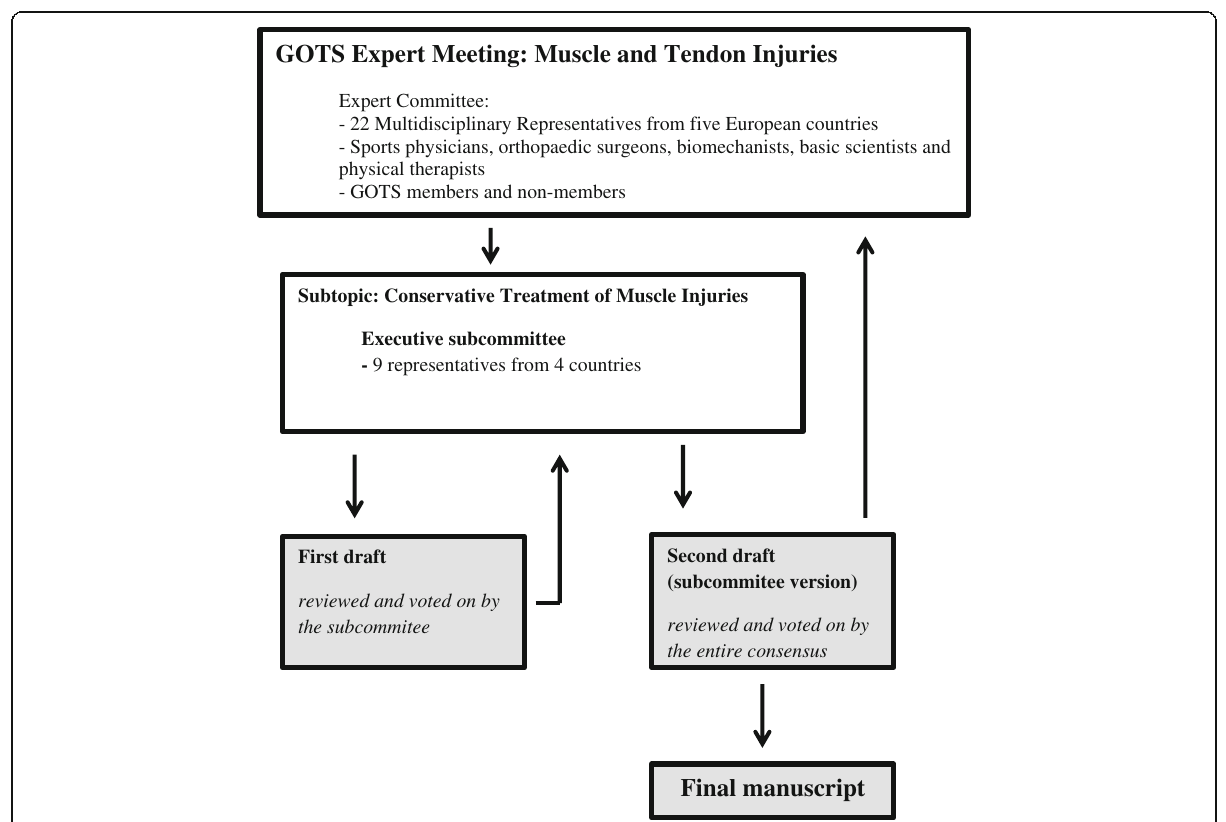
Fig. 1 Flow diagram illustrating the organization and passage of the manuscript through the 2016 GOTS Expert Meeting